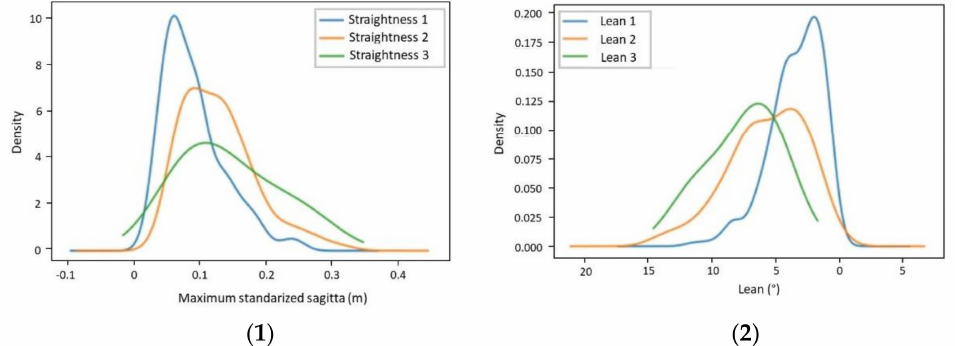
Figure 9. Probability density functions representing the values for SS max ( 1 ) and lean ( 2 ) obtained by means of the methodology/TLS using the classification from field inventory so that the three categories of trees shown in the graphic could be